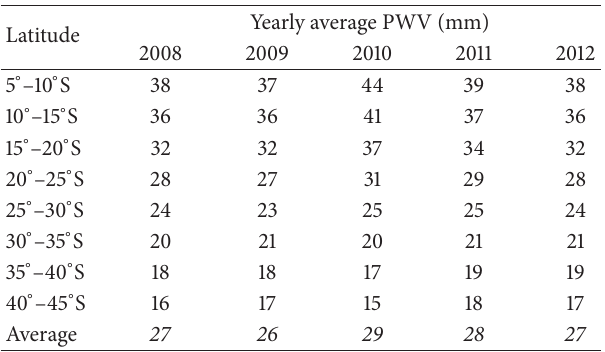
Table 8: Average of GPS PWV estimates (mm) as a function of latitude for the Australian